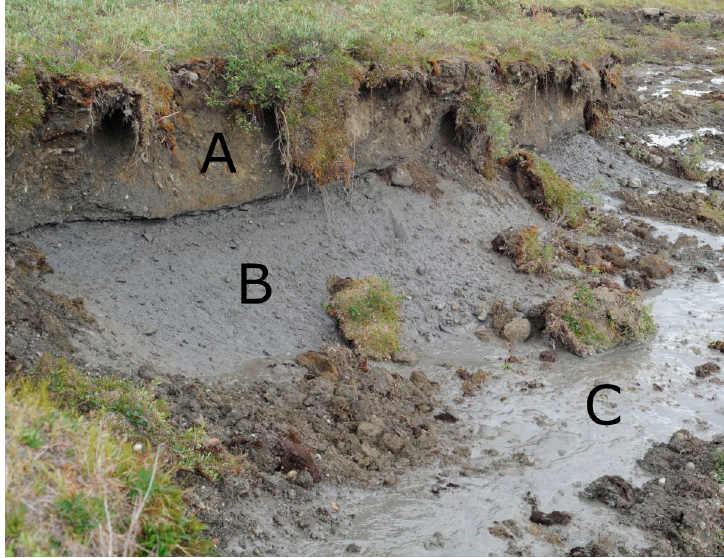
Figure 12. Main scarp of slump NOAT151 in an area that had previously slumped and revegetated. About 1.5 m of reworked glacial till ( A ) was over debris-rich glacial ice ( B ). The mud-water slurry formed by melt at the scarp is below ( C ).